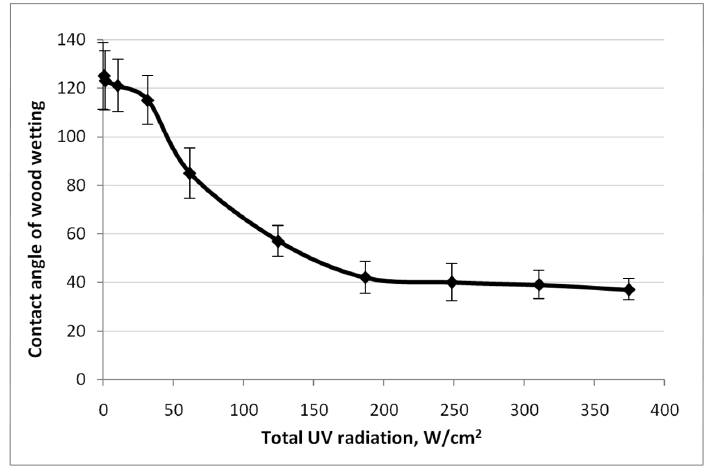
Figure 6. Change in the contact angle of wetting of pine TMW specimens depending on the total UV irradiation.